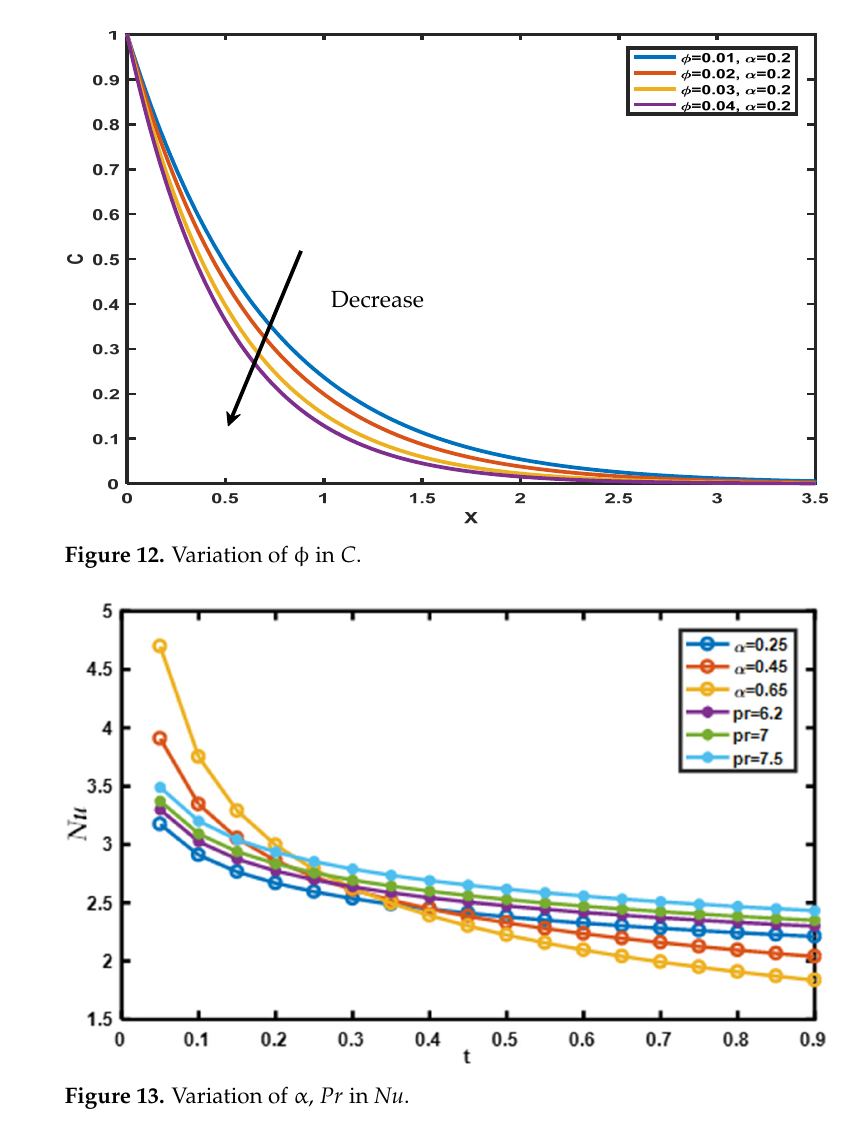
Figure 11. Variation of sc in C .